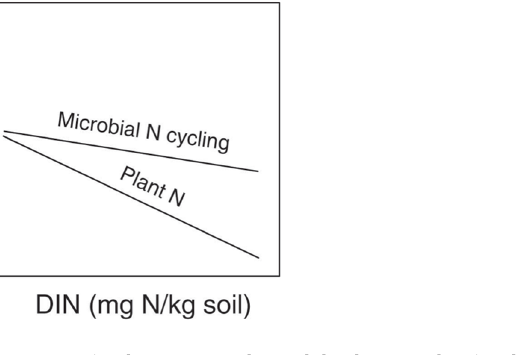
Figure 5. Revised conceptual model plant and microbial contributions to driving DIN (our indicator of R*) in this annual system. In contrast to models shown in Figure 1, in this model, DIN decreases as plant N increases due to plant uptake (Figure 3A), similar to earlier predictions (Figure 1A,B). In addition, greater plant biomass N may have been obtained through stimulation of microbial N cycling (Figure 4), in contrast to earlier predictions (Figure 1B,C).